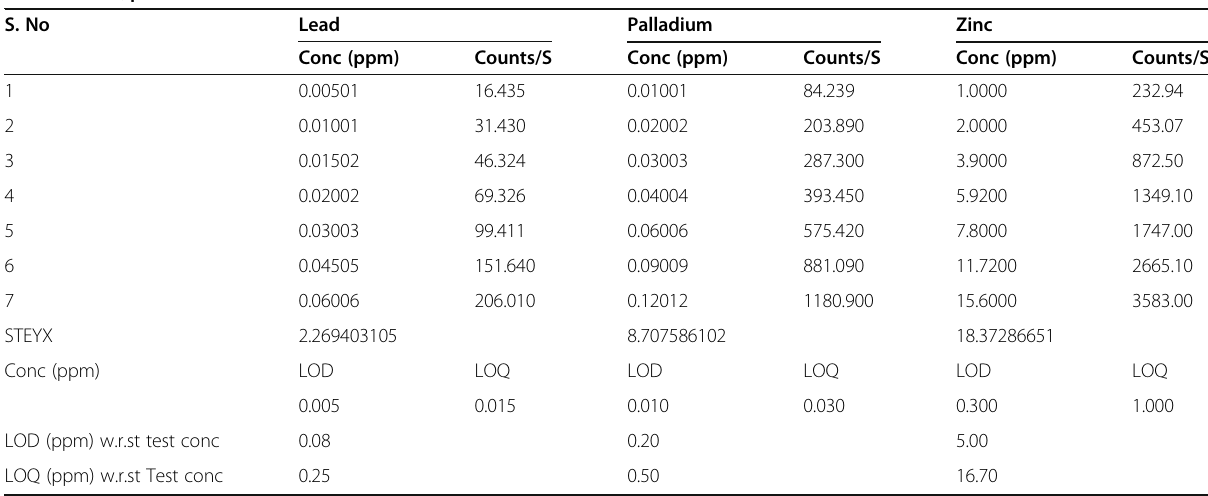
Table 2 LOD and LOQ prediction LOD and LOQ prediction